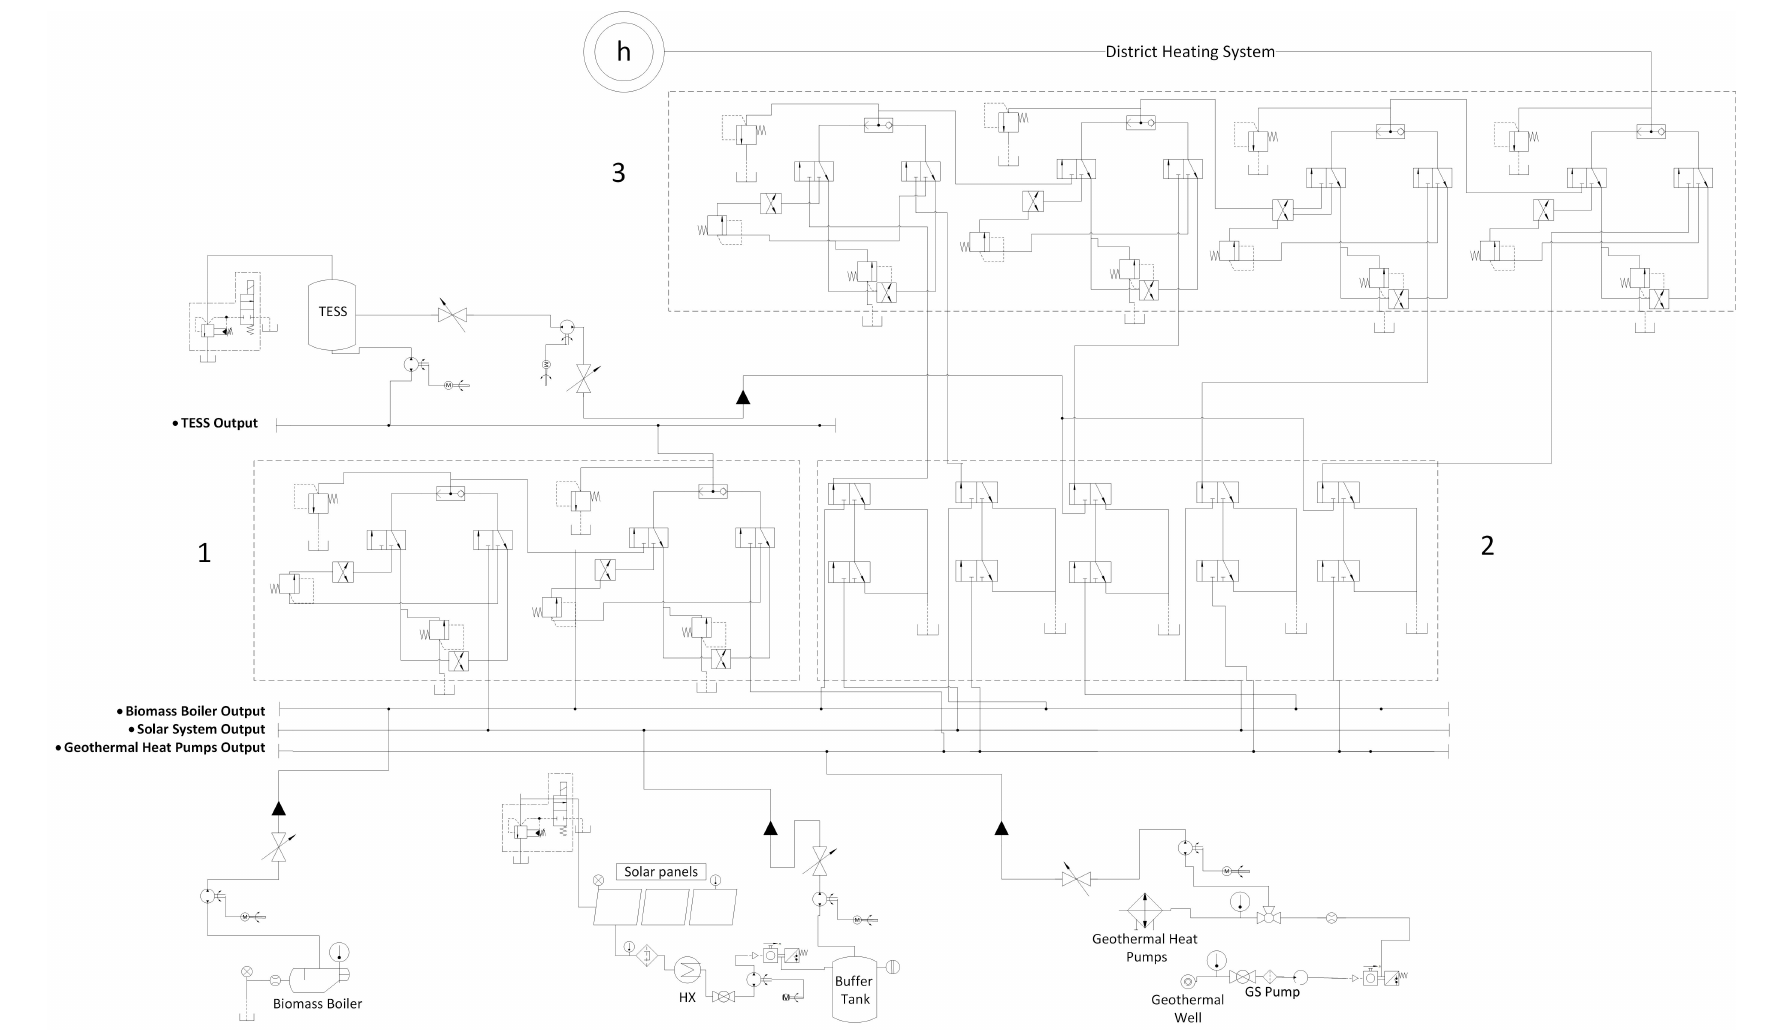
Figure 9. Proposed superstructure to cover the heating needs of the case